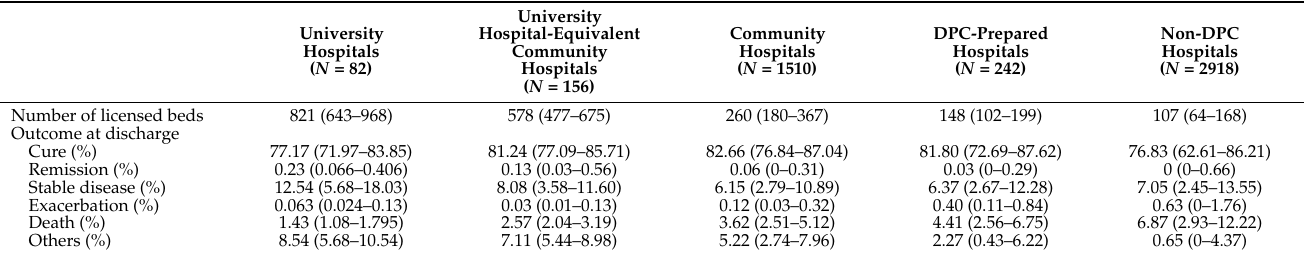
Table 1. Characteristics of hospitals stratified by facility